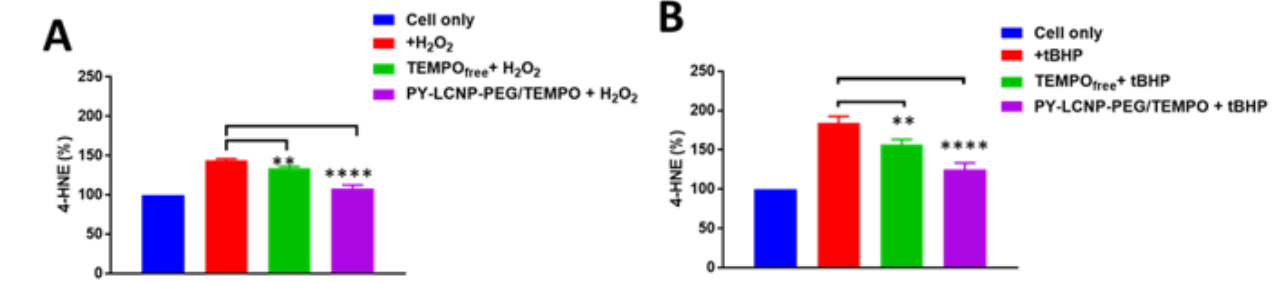
Figure 5. Lipid peroxidation assay. Quantification of cellular lipid peroxidation (% of 4-HNE) induced by 500 µ M of H 2 O 2 ( A ) and tBHP ( B ) with or without labeling with PY-LCNP-PEG/TEMPO and TEMPO free . Data plotted as change (%) in average (n = 3 ± SEM) compared to control cells (not treated with H 2 O 2 ) (** p < 0.005; **** p < 0.0001).